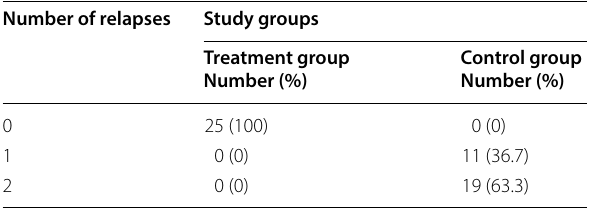
Table 3 Number of relapses in each study group during the 12-month study period